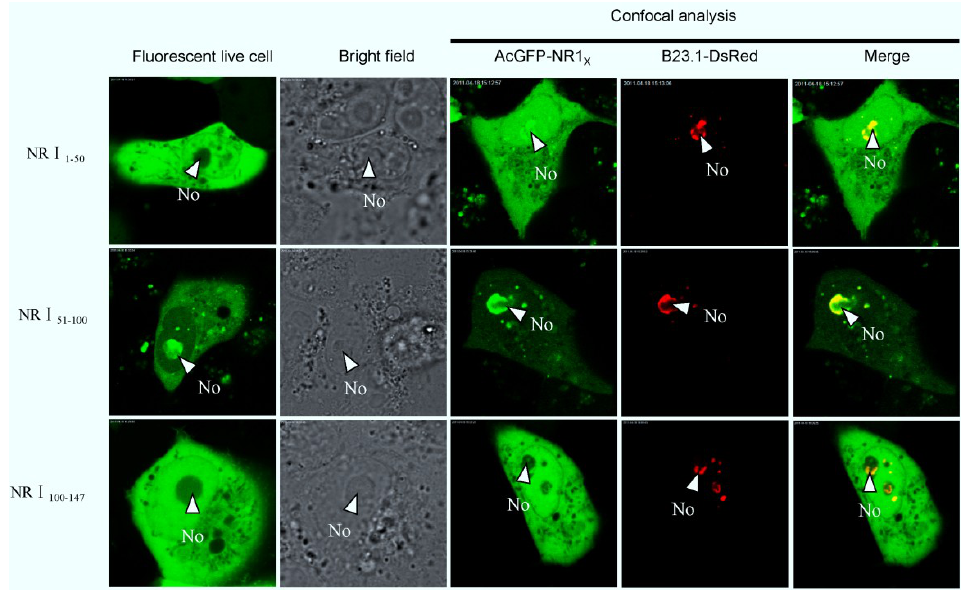
Figure 4. Live cell and confocal microscopy of the sub-cellular localization of fluorescent fusion proteins: AcGFP-NR1 , AcGFP-N1 , AcGFP-N1 . The PEDV fusion 1–50 51–100 100–147 peptides are colored green and the B23.1 fusion protein colored red. Merged images are also presented. The nucleolus (No) is arrowed where appropriate.